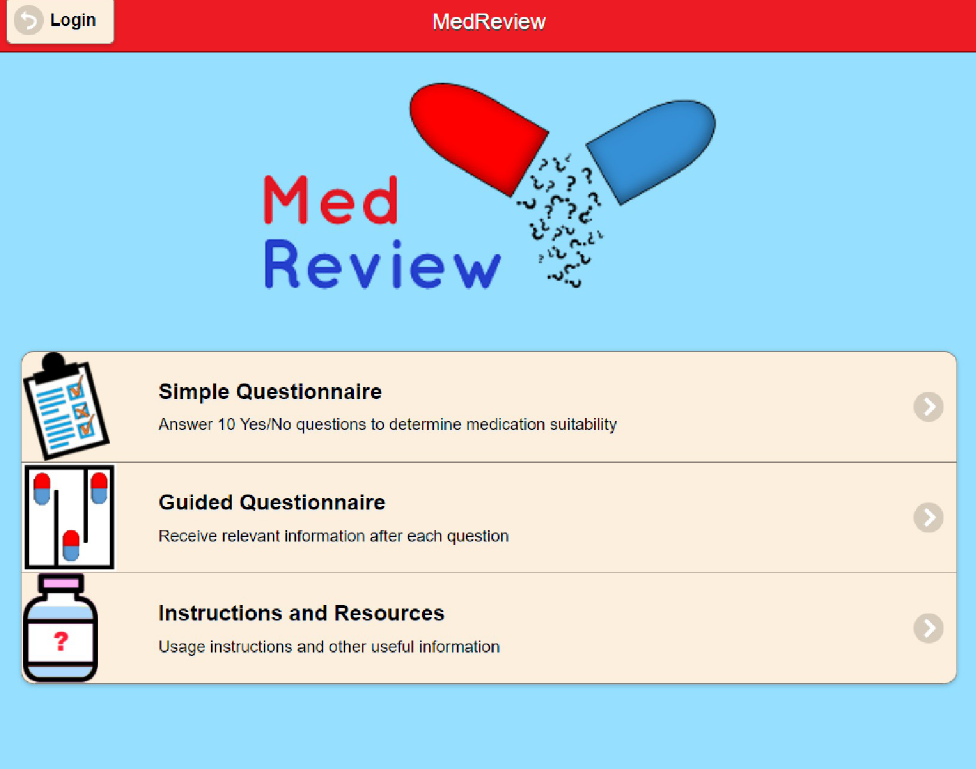
Fig 1. Screenshot of the home page of